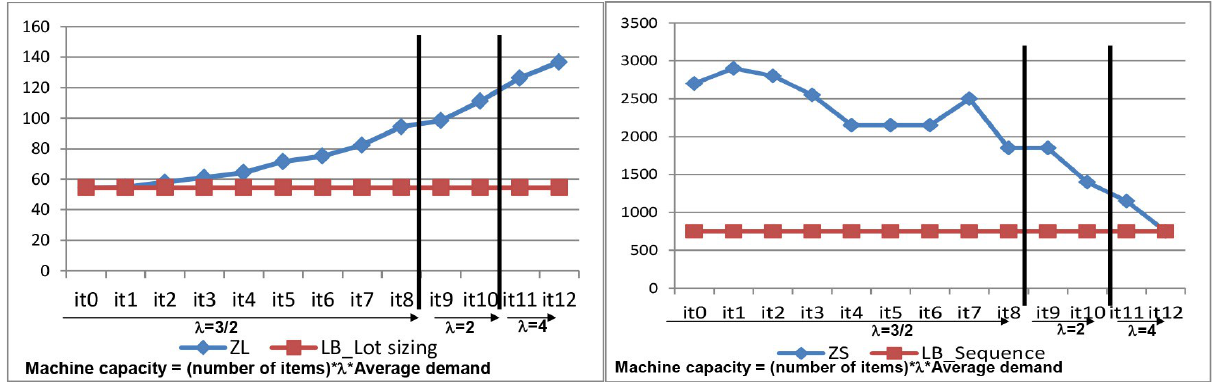
Figure 2. Lot sizing cost and its lower bound Figure 3. Scheduling cost and its lower bound